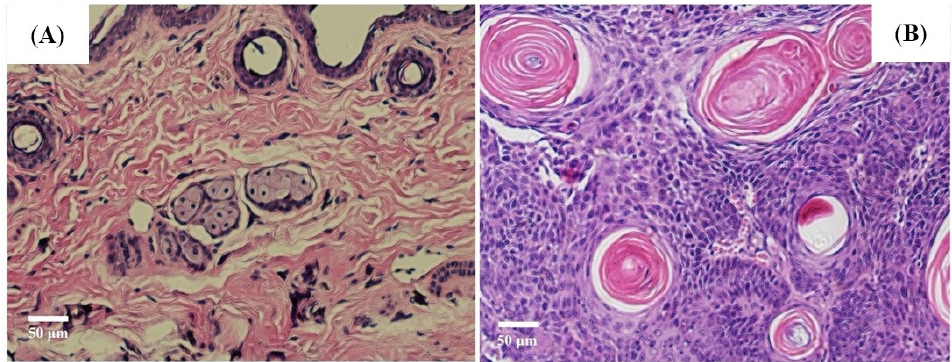
Figure 2. Histological staining of mice exposed to UVR. ( A ) Normal skin; ( B ) cSCC. 3.2. The Features on the cSCC Images Were Highlighted after Segmentation A total of 5 images in each histological sample of 13 wavelengths for 65 multispectral grayscale images were taken by microscopic MSI system based on LED illumination. Mul- tispectral grayscale images can use spectral dimensions to accurately display the morpho- logical characteristics of different tissues. Figure 3 shows the single-band and pseudo- color composite images of the mouse skin’s normal and cSCC tissue areas, with 3A and 3B displaying the single-band and composite pseudo-color images of the cSCC tissue slide